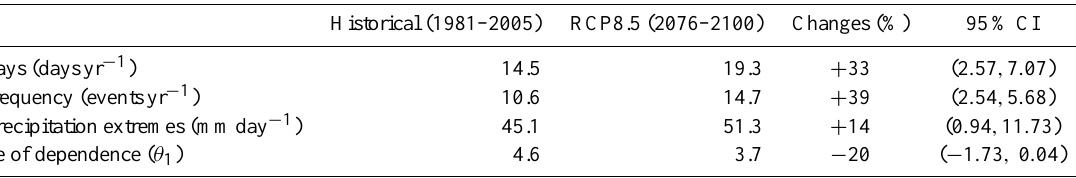
Table 3. Summary: Change in atmospheric river properties from multi-model ensemble outputs under late 21st century RCP8.5 forcing compared to the recent past (historical). There are increases in AR days, AR frequency, and heavy rainfall associated with ARs, while spatial dependence between the annual maximum AR precipitation decreases in the future under a warming scenario. The 95% confidence interval (CI) is calculated for the difference in means (RCP8.5 run − historical run) of each AR property.